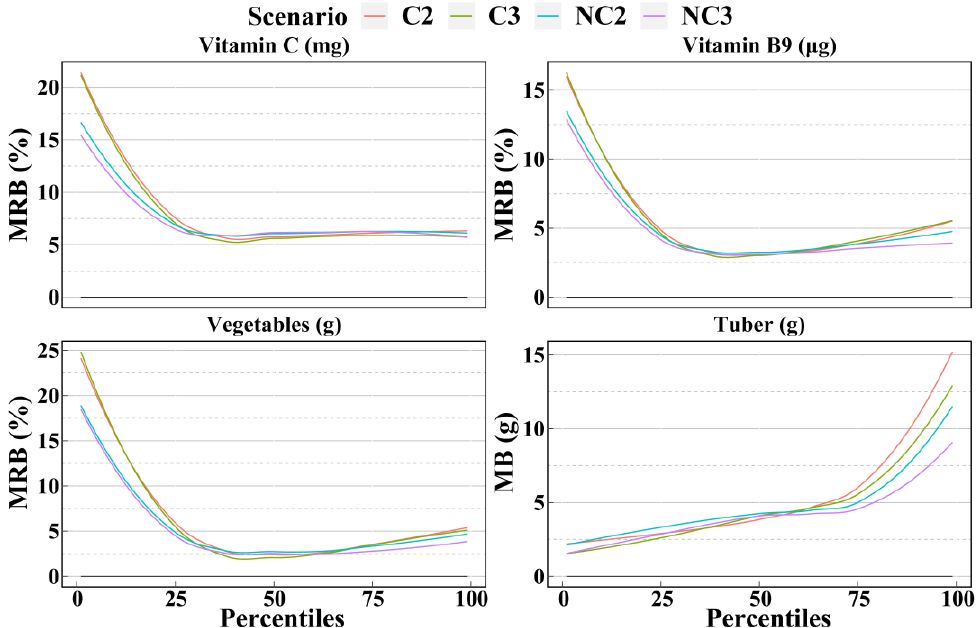
Figure 4. Smooth curves of the percentile (from 1st to 99th) intakes of dietary components in group 2 as calculated by the NCI method based on the 4 scenarios. Smooth curves of bias and relative bias for 10 dietary components calculated by the 4 scenarios are available in Supplementary Figure S3. C2 = 2 consecutive days; C3 = 3 consecutive days; NC2 = 2 non-consecutive days; NC3 = 3 non-consecutive days; MRB = Mean relative bias; MB = Mean bias.